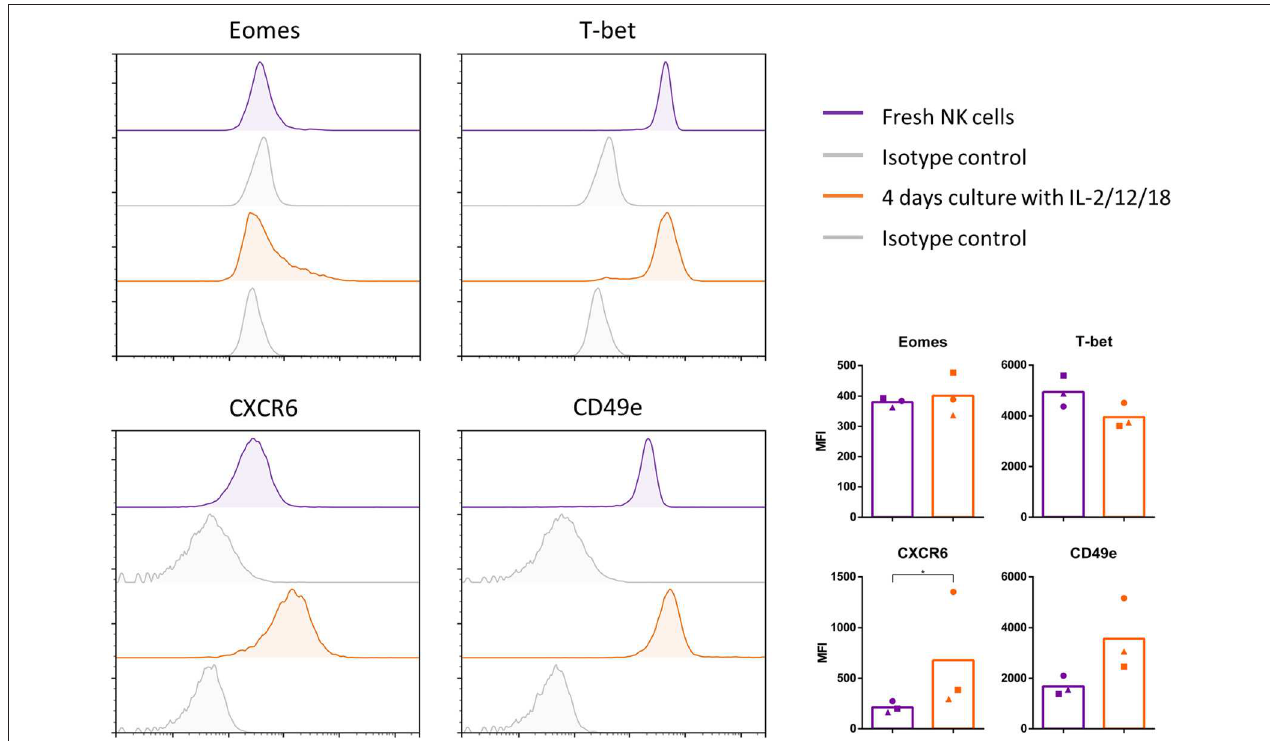
FIGURE 5 | Conventional Eomes low blood NK cells show some degree of plasticity with regard to phenotypic expression marker profile. NK cells were sorted from blood, examined for their expression of Eomes, T-bet, CXCR6, and CD49e (purple) and cultured for 4 days in the presence of IL-2/12/18 (orange). Afterwards, cells were examined for their expression of Eomes, T-bet, CXCR6, and CD49e. Flow cytometric histrograms of the signals and isotype controls (gray) are shown. Graphs show the median fluorescence intensity (MFI), showing individual data points for three different animals, and the mean value indicated by the bar. A logarithmic scale was used for the x-axis. Statistically significant differences are indicated with an asterisk (* p <